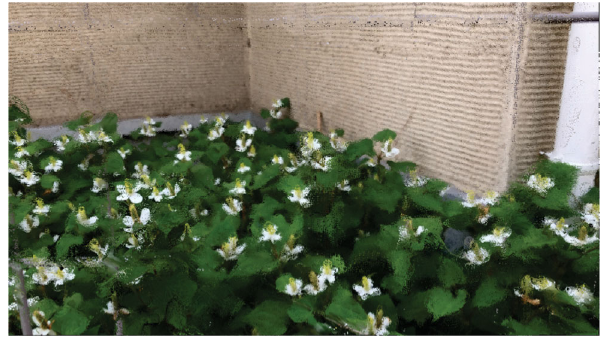
Fig. 6 Blending results using fence-aware LFR for camera data D i .